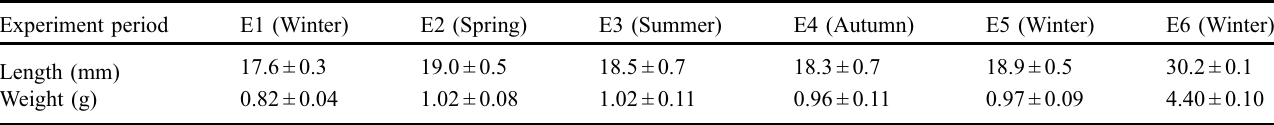
Table 2. Mean initial length (mm), mean weight (g),andcon fi dence intervals ( a = 0.05) of abalone used in each experiment. Experiment